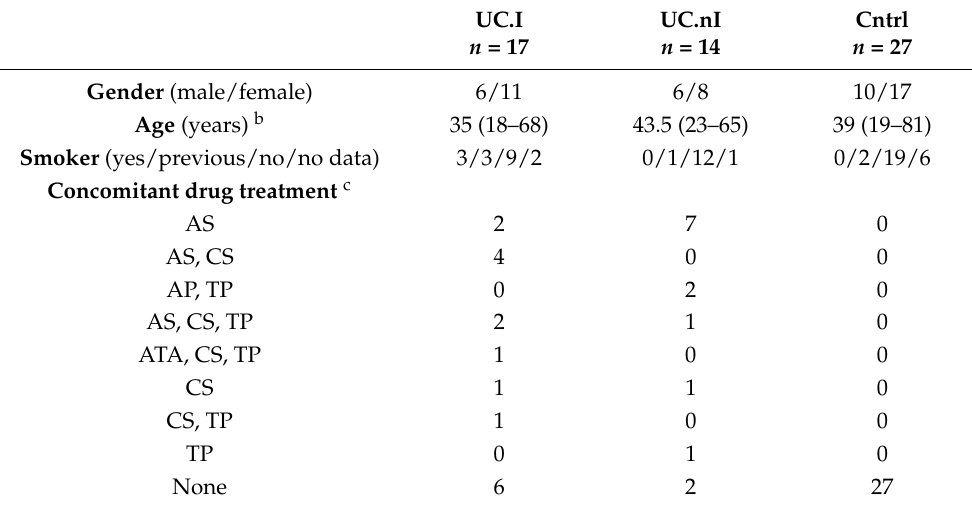
Table 1. Characteristics of patients with ulcerative colitis ( n = 31) and non-inflamed controls ( n = 27) a .